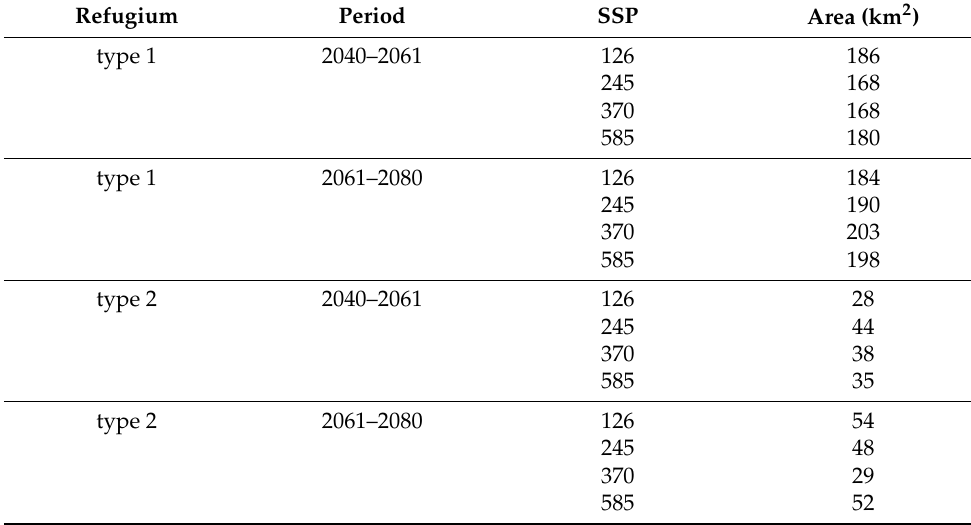
Table 7. Extent of two types of refugia (km 2 ) for Eurasian Pygmy Owl (Glaucidium